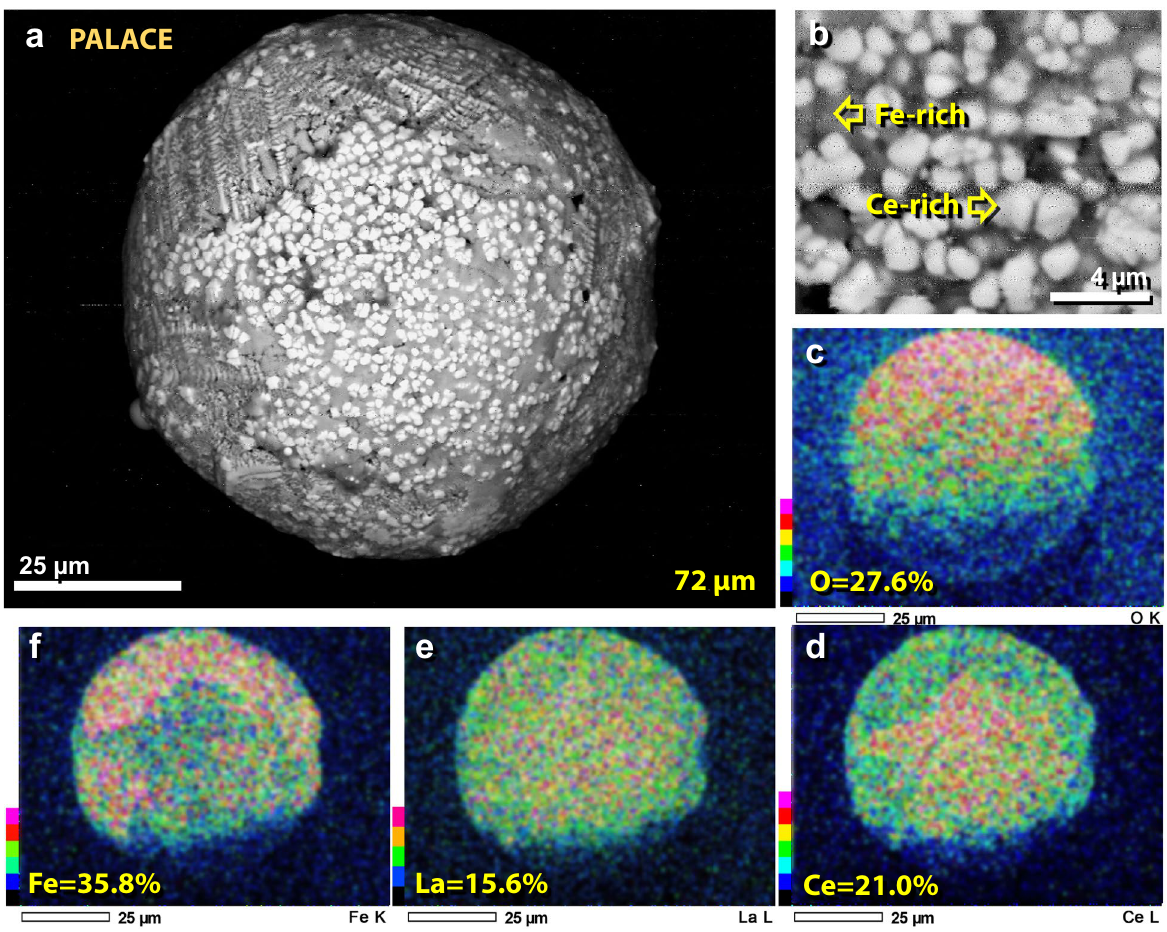
Figure 26. SEM image of rare-earth (REE) spherule. ( a ) REE-rich 72-µm-wide spherule from the palace, dominantly composed of Fe, La, Ce, and O. ( b ) Close up of REE blebs found on the spherule. ( c )–( f ) SEM–EDS elemental maps showing composition. La = 15.6 wt.% and Ce = 21.0 wt.%. Ce is enriched over Fe and La in the middle part of the spherule, as seen in panels ‘ d ’ through ‘ f ’.